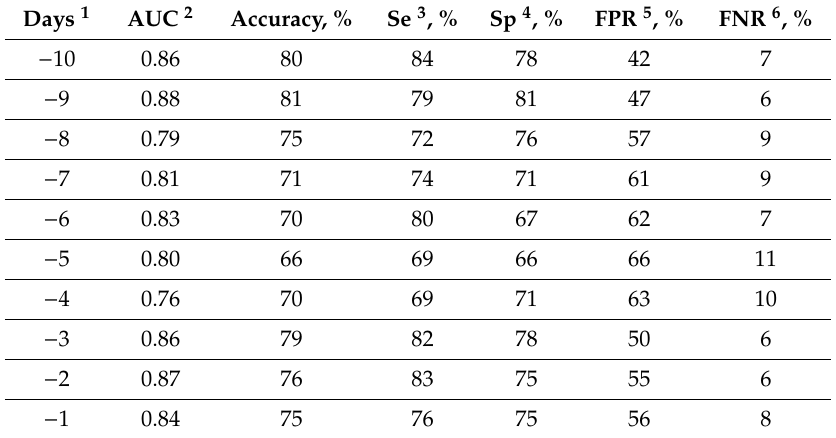
Table 2. Outcomes of the diagnostic test characteristic resulting from the prediction models of the training database from days before the treatment event of sick